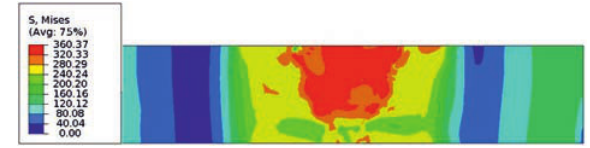
Fig. 4. Distribution of von Mises stresses, MPa